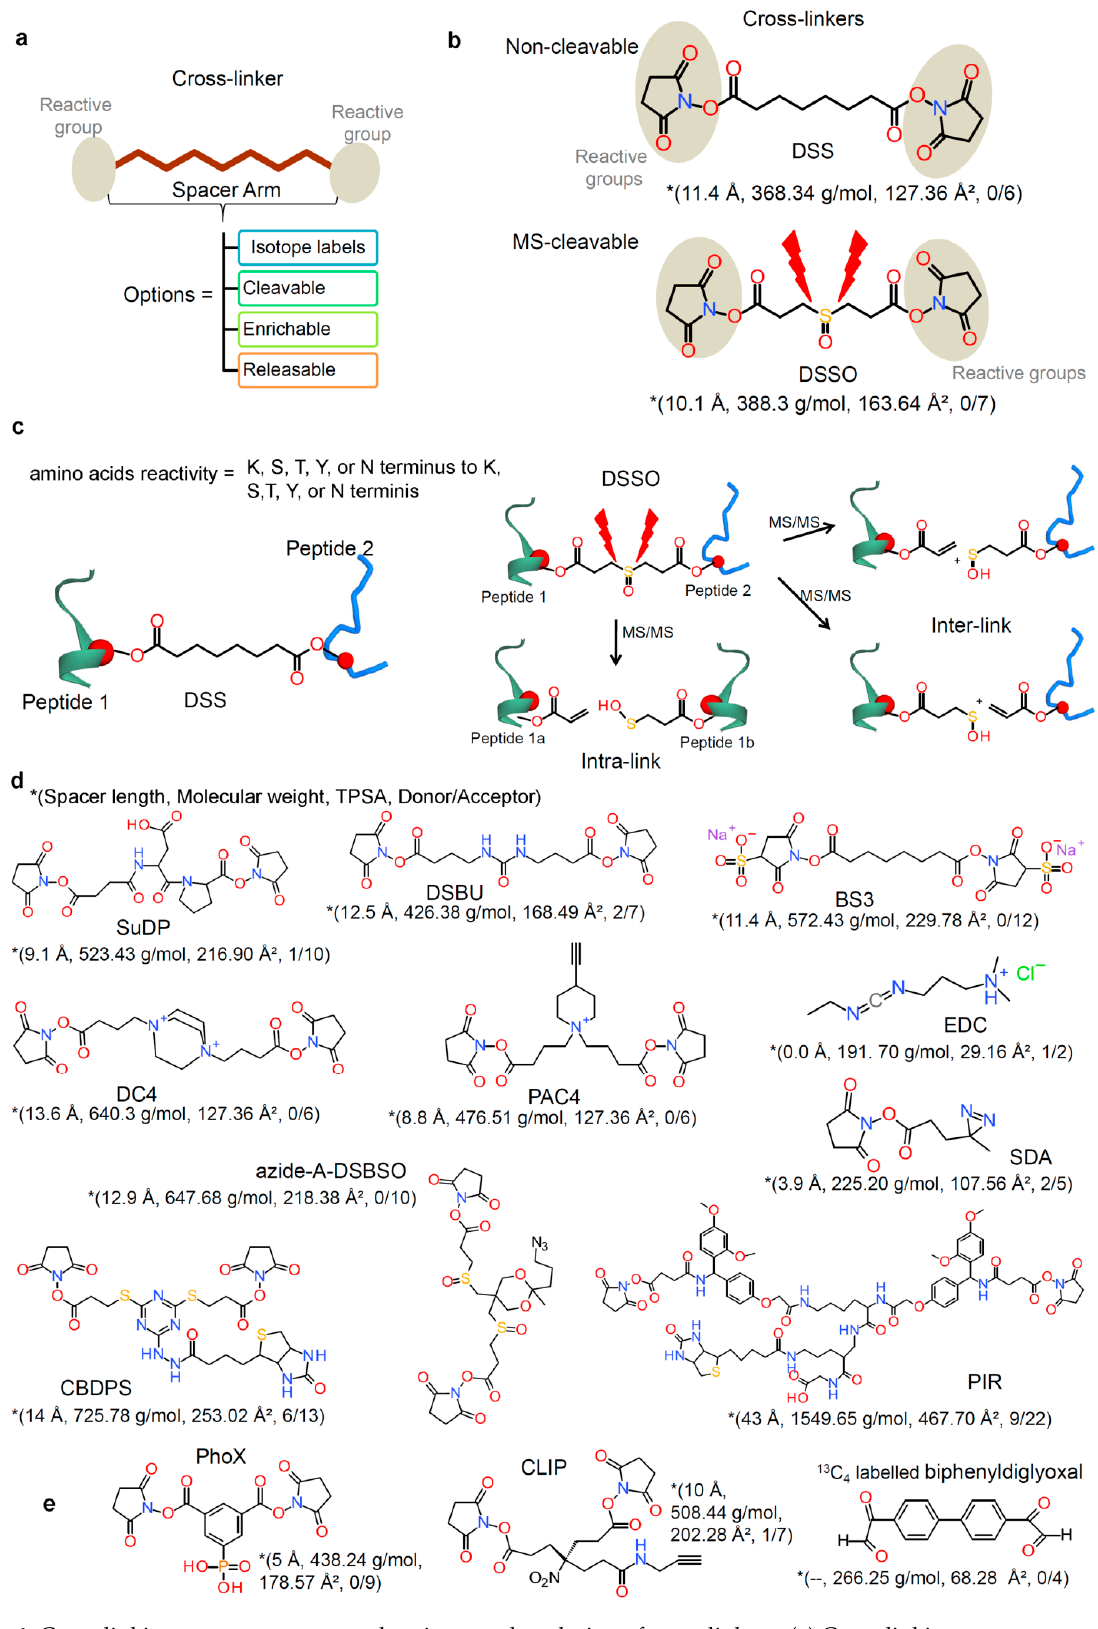
Figure 4. Cross-linking reagents anatomy, chemistry, and evolution of cross-linkers. ( a ) Cross-linking reagents comprise various reactive groups, spacer scaffolds with different lengths. Based on the applied experimental workflow, a variety of isotope labeled, cleavable, enrichable, releasable, and spacer groups are in use. A large number of cross-linkers establish